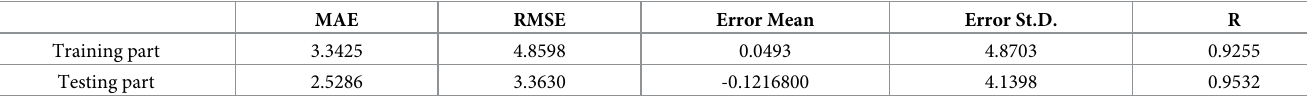
Table 1. Summary of the statistical measures for the training and testing datasets. MAE RMSE Error Mean Error St.D.